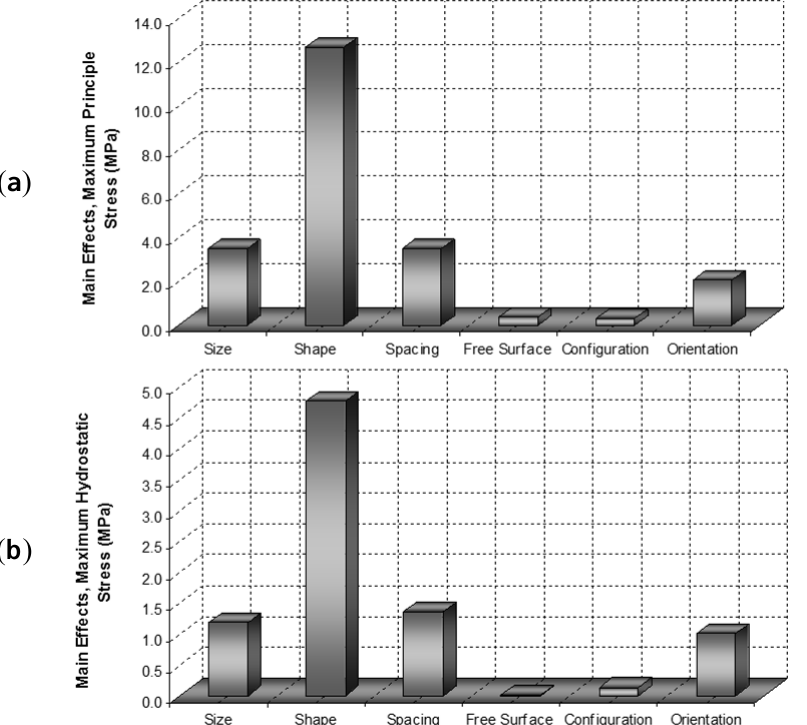
Figure 26. The influence of casting parameters on ( a ) Maximum principal stress; ( b ) Maximum hydrostatic stress (half of the particles are pre-fractured)